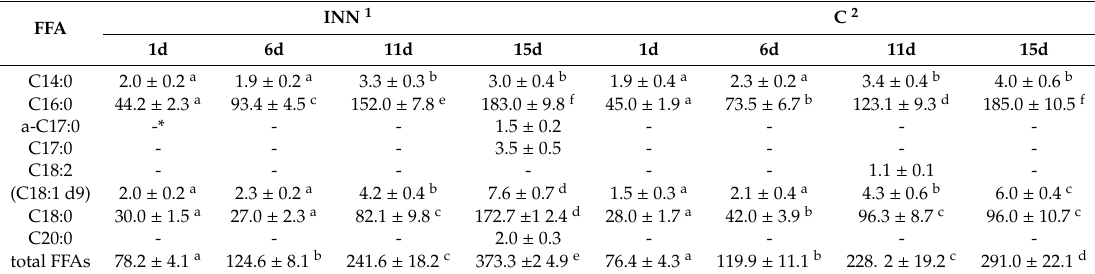
Table 4. Free fatty acid (FFA)concentration (ppm) in innovative and traditional Squacquerone cheeses after 1, 6, 11, and 15 days of refrigerated storage. In the same line, for each FFA, means ± SD followed by di ff erent superscript letters ( a–f ) are significantly di ff erent, p <